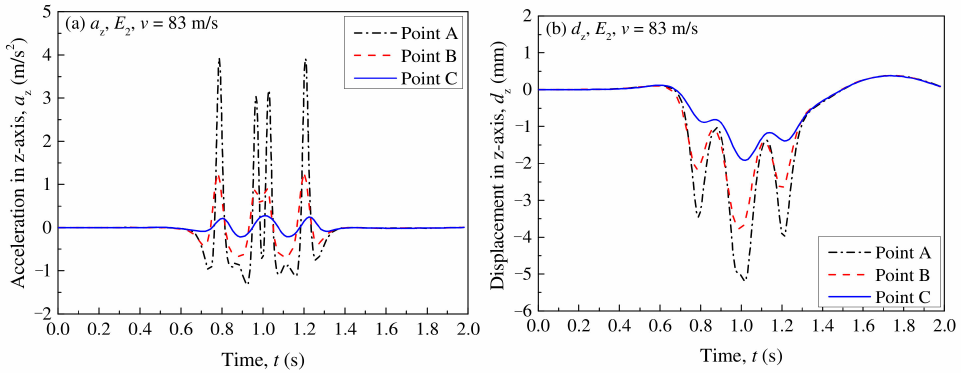
Figure 7. Vertical acceleration/displacement at different points: ( a ) a z ; ( b ) d z